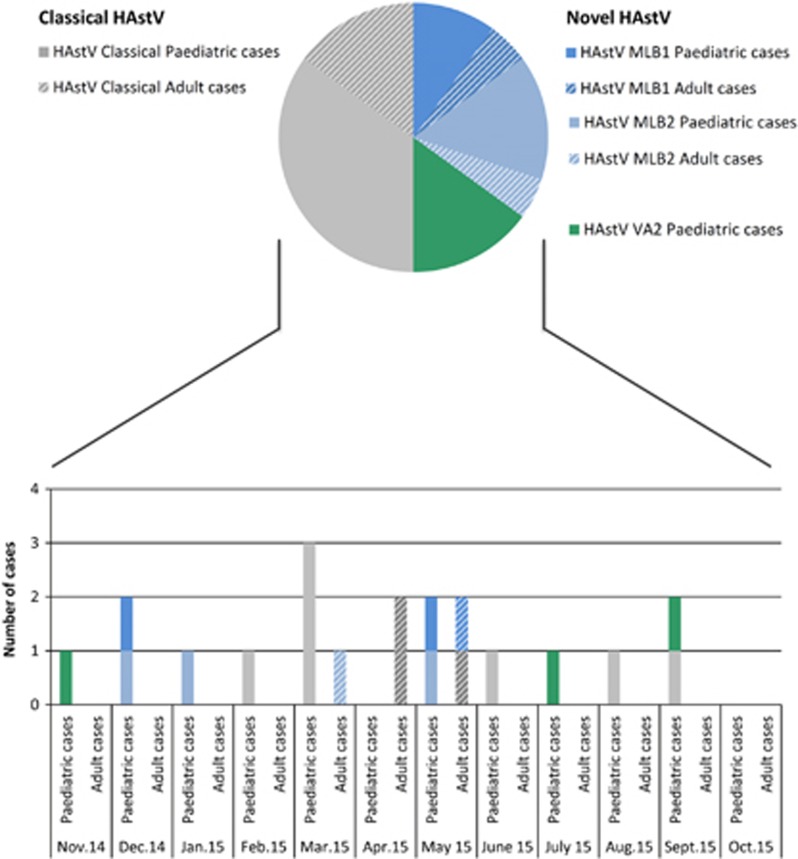
Positive human astroviruses in stool samples. Top: Pie chart showing the prevalence and composition of classical and novel astroviruses among HAstV-positive patients. Bottom: histogram of the temporal distribution of cases. human astrovirus, HAstV.